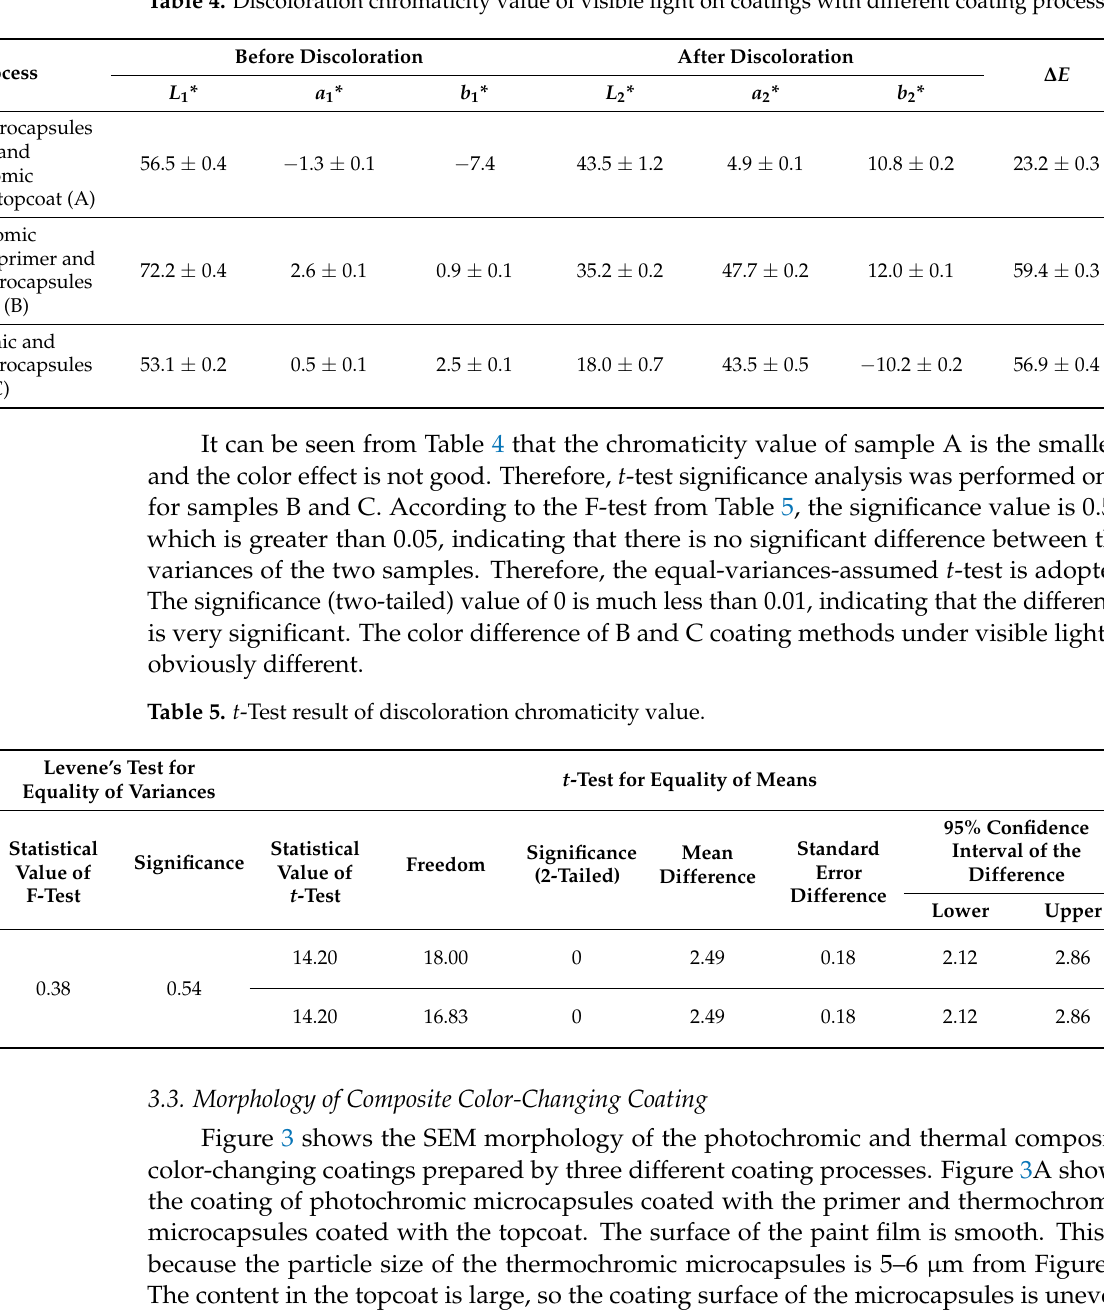
Table 4. Discoloration chromaticity value of visible light on coatings with different coating processes.